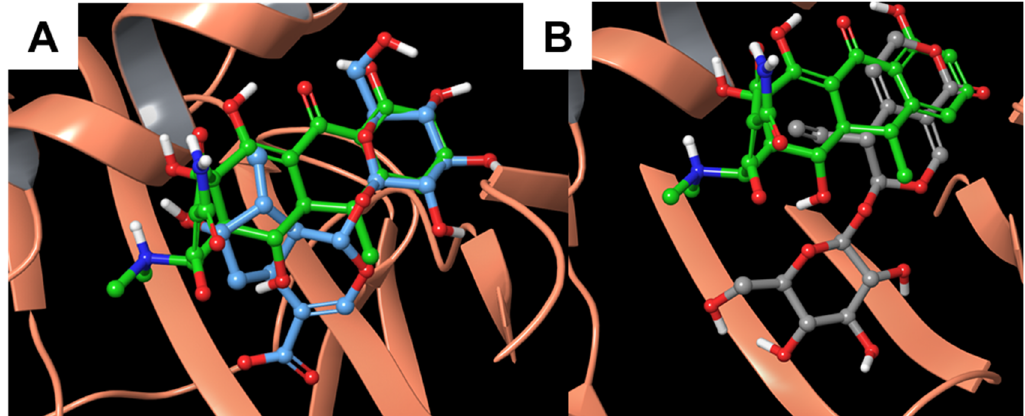
Figure 4. Superimposition between the co-crystallized doxycycline and ( A ) 1 and ( B ) 2 inside the alpha-1-antichymotrypsin binding site (PDB: 5OM2 [41], orange ribbons).